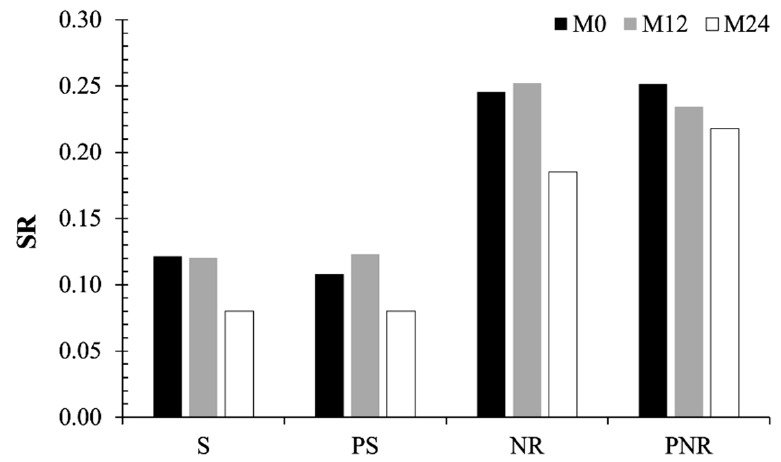
Figure 5. Solar reflectance of the black-coloured specimens in months M0, M12, and M24. The standard black (S) showed a reduction of 33% in the solar reflectance, between M0 and M24, while for NR was 25%. Considering the specimens with primer layer, the difference between M0 and M24 was 25% and 13% for PS and PNR, respectively. In both cases, the incorporation of NIR reflective pigments had a positive effect to keep the solar reflectance values. These results are in line with previous studies developed by Paolini et al. [65] and Rosso et al. [69], where a loss of reflectance with the ageing effect was also observed. A standard black colour should have a spectral reflectance curve, on the Vis region, near to 20%, and colours with NIR reflective pigments should be focussed on the NIR region since it is where their performance is enhanced. The colour variation can affect the reflectance in the visible range of the solar spectrum, which contributes to 42% of the solar reflectance, according to Equation (2). To evaluate this effect, the contribution of NRP in the different regions was analysed in Month 24 with the aid of a spectrophotometer (see Figure 6).